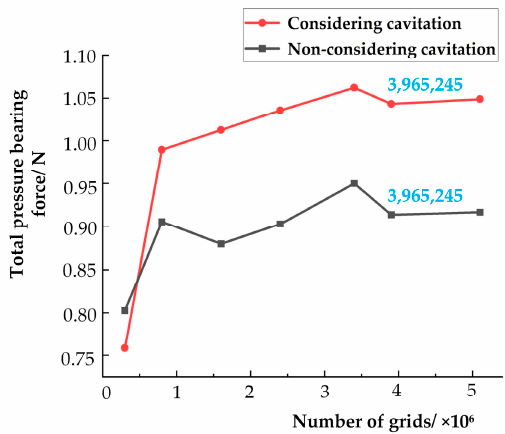
Figure 4. Verification of grid independence.